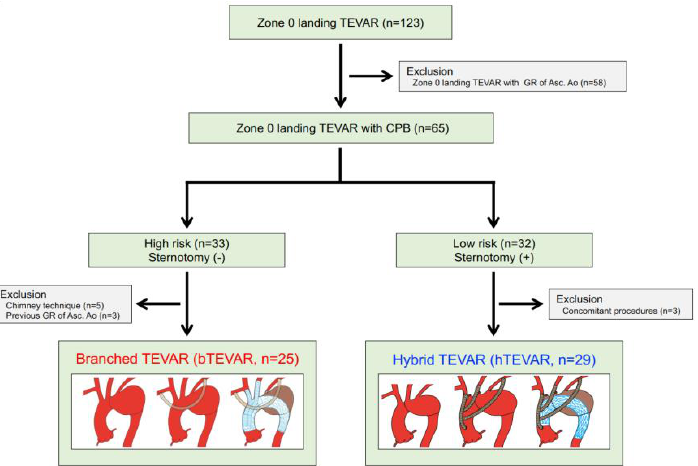
Figure 1. Treatment algorithm of this study. TEVAR: thoracic endovascular aortic repair; GR: graft replacement; Asc. Ao: ascending aorta; bTEVAR: branched TEVAR; hTEVAR: hybrid TEVAR.